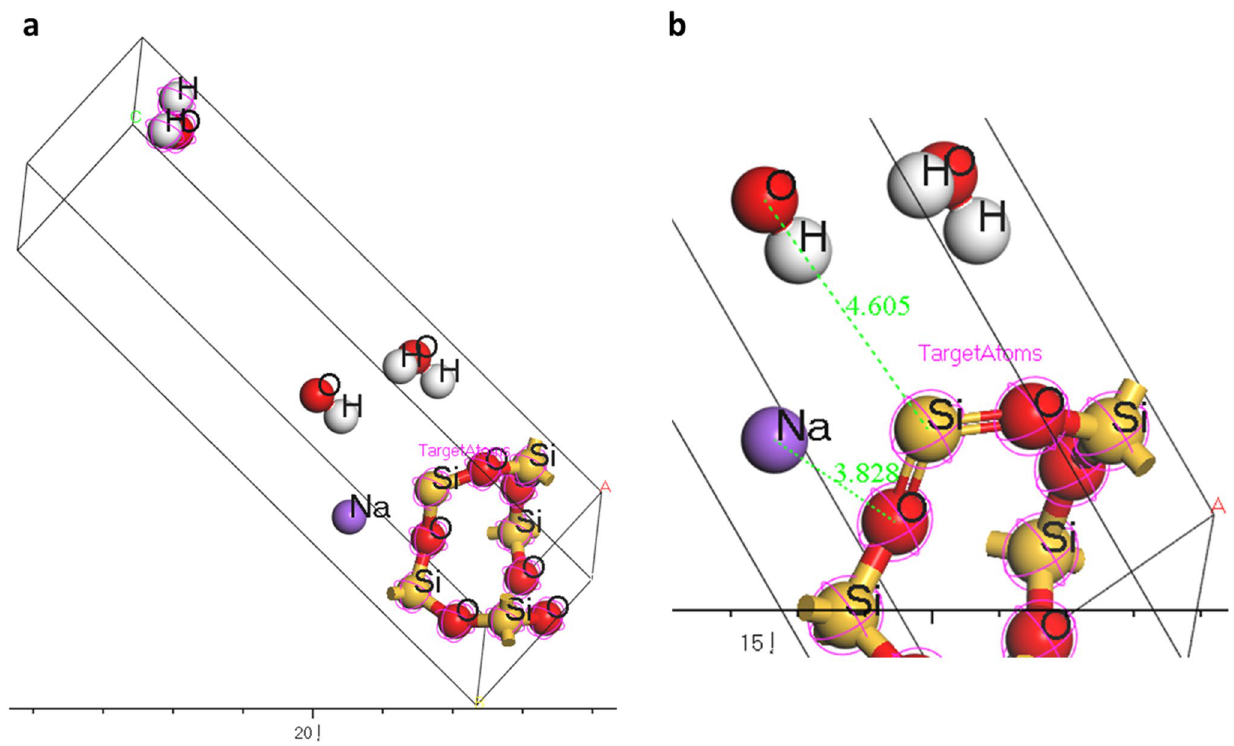
Fig. 15 a Dissociative adsorption model of NaOH on quartz, b zoomed in view of the adsorption